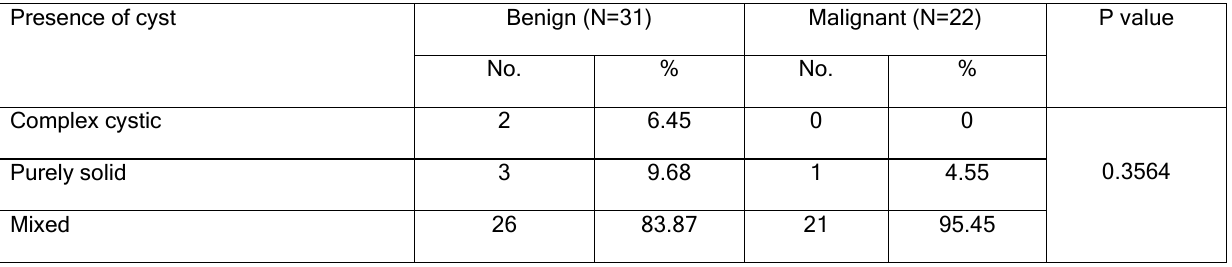
Table 2: Difference between benign and malignant ovarian lesions regarding the tumor composition. Presence of cyst